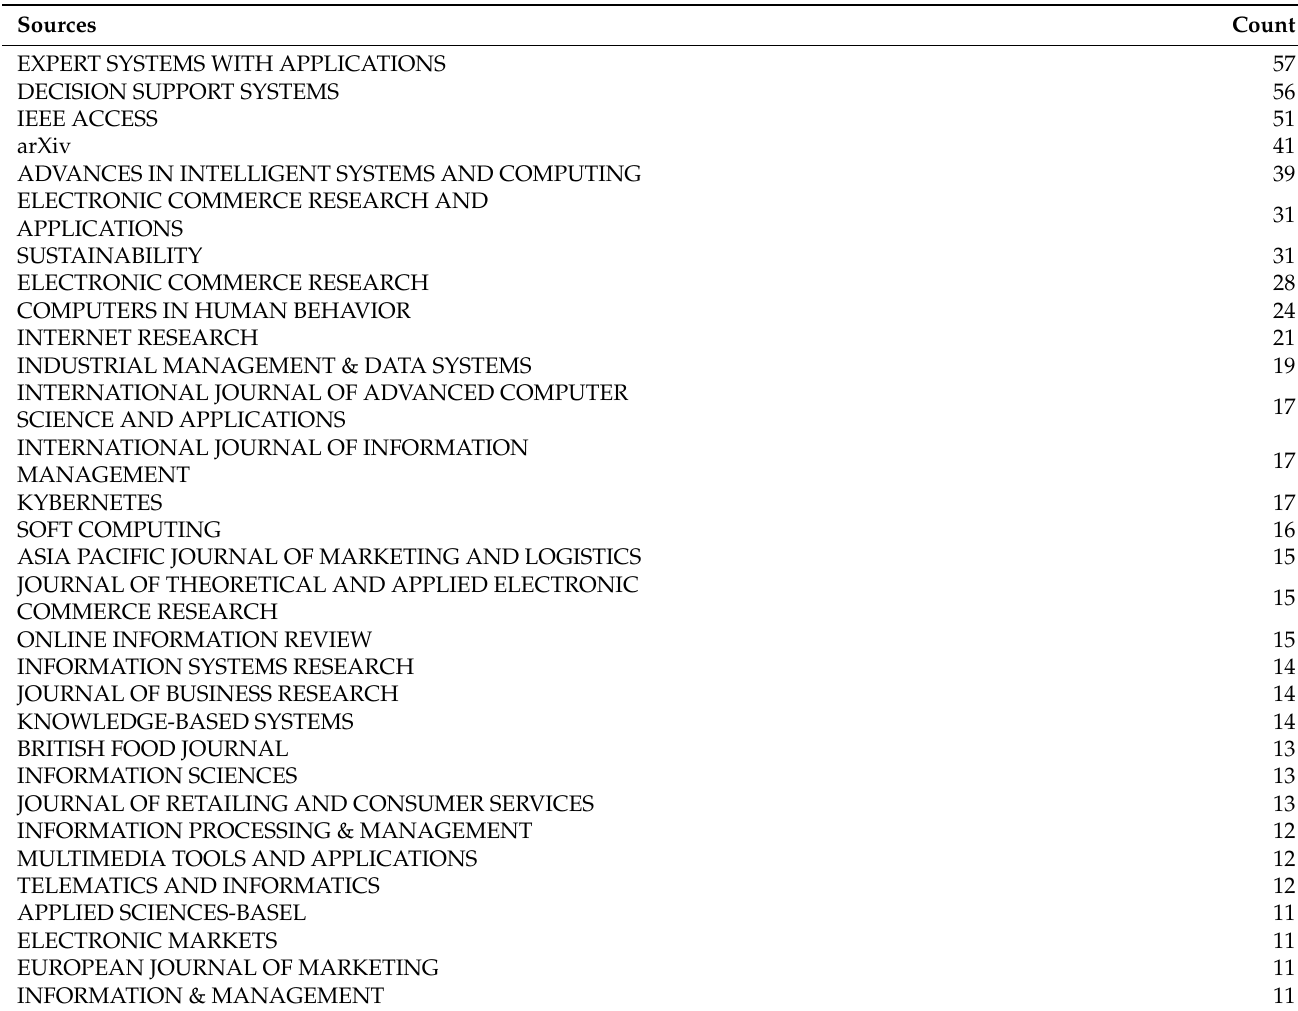
Table 1. List of journals and counts.